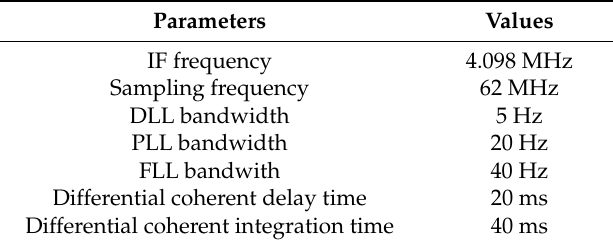
Figure 15. The tracking result of satellite #9. 0